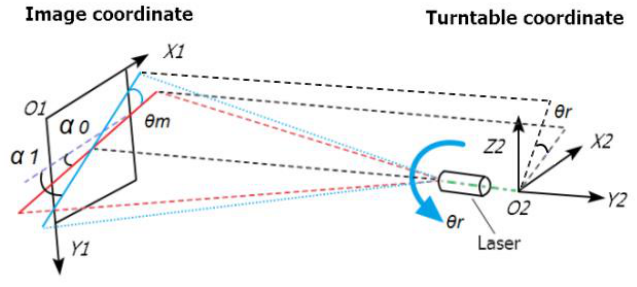
Figure 18. Schematic diagram of the experiment principle.